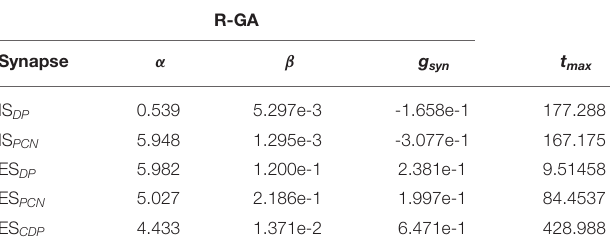
TABLE 1 | Relevant synaptic parameters of the GA adjusted to recorded Gnathonemus petersii patterns (R-GA, refer to Figure 2 ) configurations of the model ( threshold = 0; E syn = − 80; T = 1; refer to Equations 4,